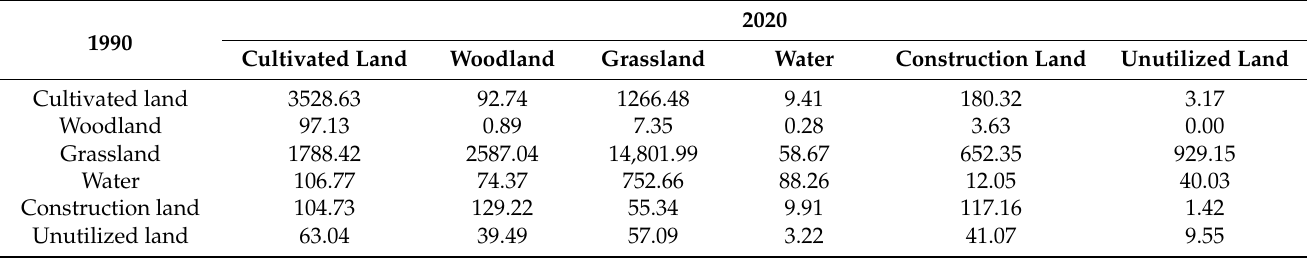
Table 4. Land-use transfer matrix in Baotou City during the 1990–2020